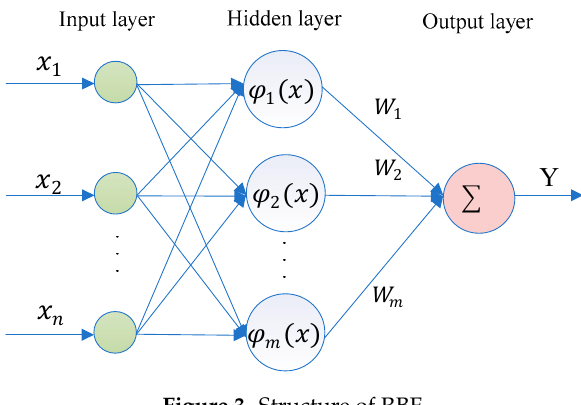
Figure 3. Structure of RBF.